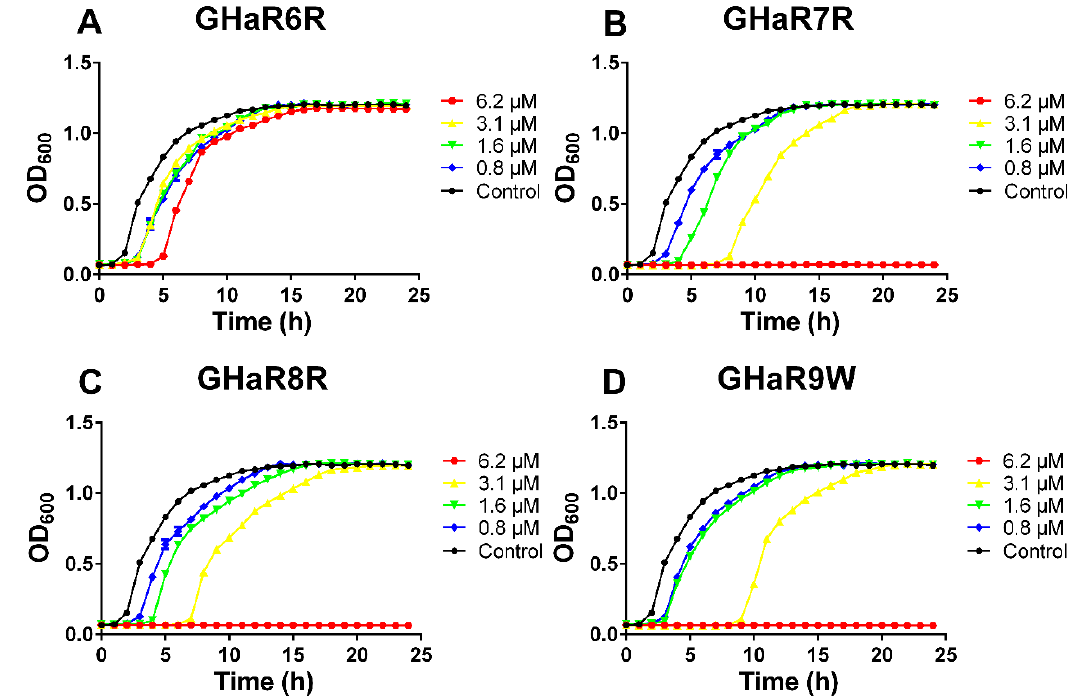
Figure 3. The growth inhibition curves of ( A ) GHaR6R, ( B ) GHaR7R, ( C ) GHaR8R, and ( D ) GHaR9W against S. mutans that were grown in Brain Heart Infusion Broth (BHI) for 24 h. Non-treated bacteria were served as the negative control.